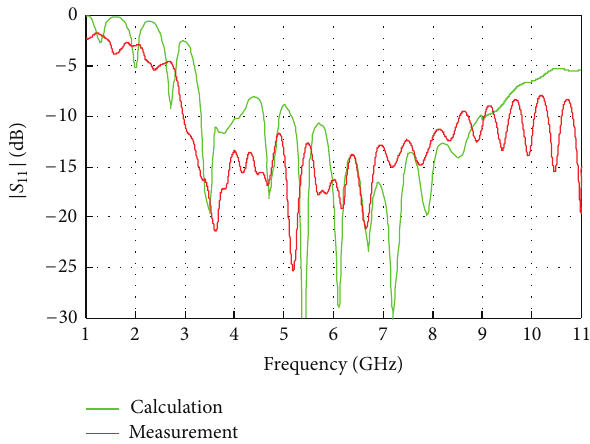
Figure 7: Input characteristics for rolled UWB